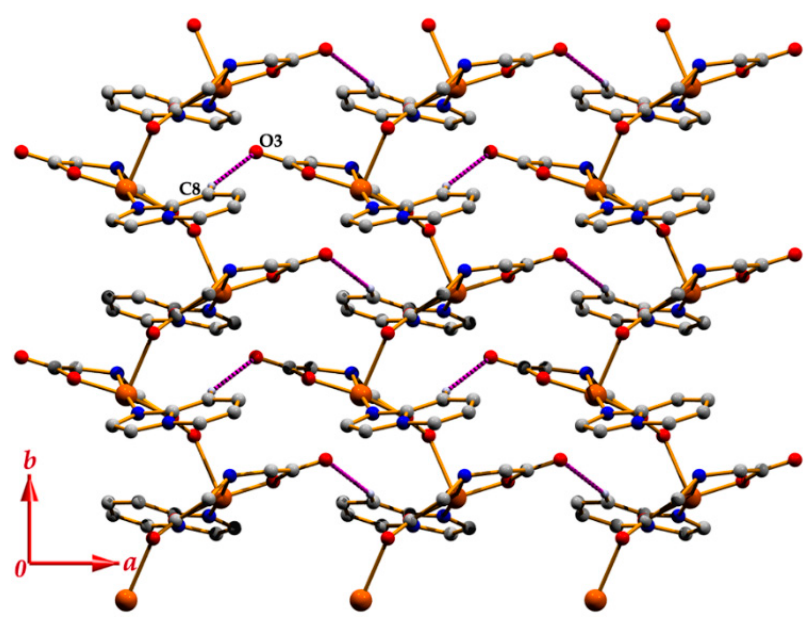
Figure 2. 1D polymeric chains are interconnected through C–H ∙∙∙ O hydrogen bond to generate a layered assembly in (110) plane.